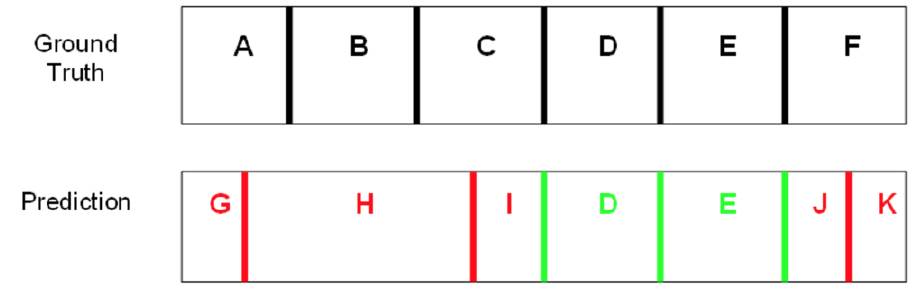
Figure 6. An example of how domain predictions are scored. Green boundaries indicate correct predictions. Domains marked with green letters indicate correctly predicted domains. Red boundaries indicate incorrect predictions. Domains marked with red letters indicate incorrectly predicted domains. A domain is only considered to be correctly predicted if both boundaries align with the ground truth. In this example, the true positives (TP) are D and E; the false positives (FP) are G, H, I, J, and K; and the false negatives (FN) are A, B, C, and F. Three key performance metrics, i.e., sensitivity, positive predictive value (or preci- sion rate), and the Jaccard index, were compared side by side on identical benchmark simulations for isoPlotter and isoSegmenter as